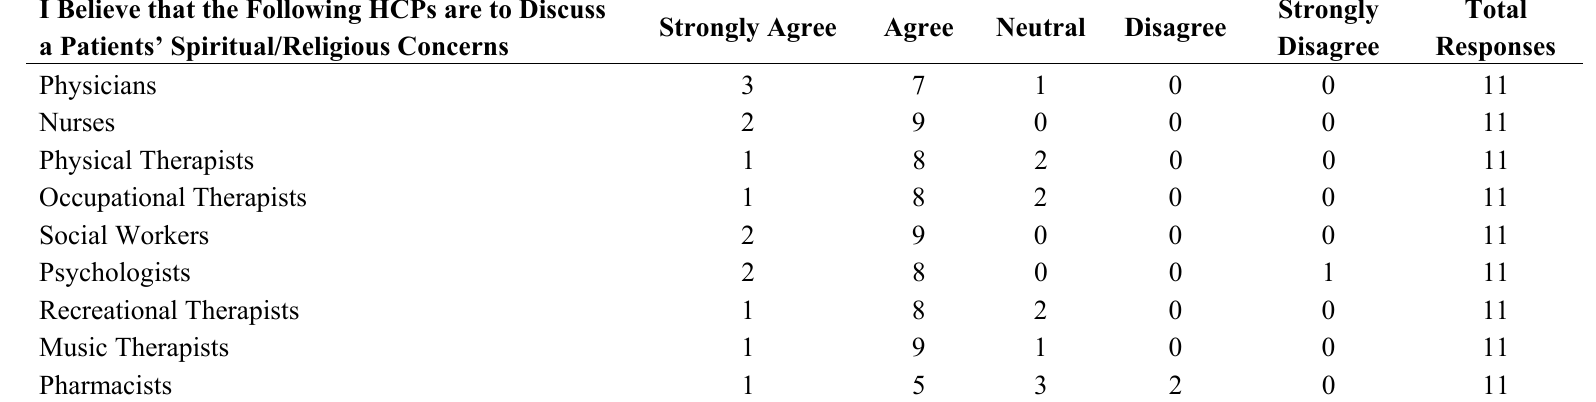
Table 2. Perspectives regarding IP roles & responsibilities regarding spirituality.